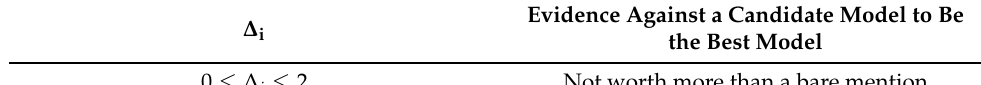
Table 3. Rules of thumb [37] for ∆ i = BIC i − BIC min . ∆